Question: How would you classify this visualization?
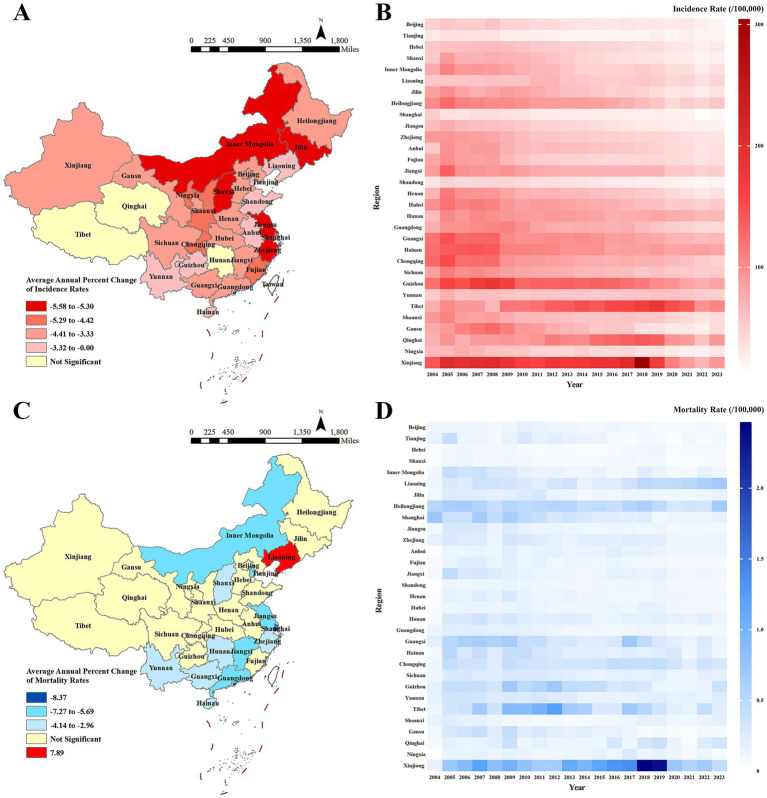
Answer: heatmap